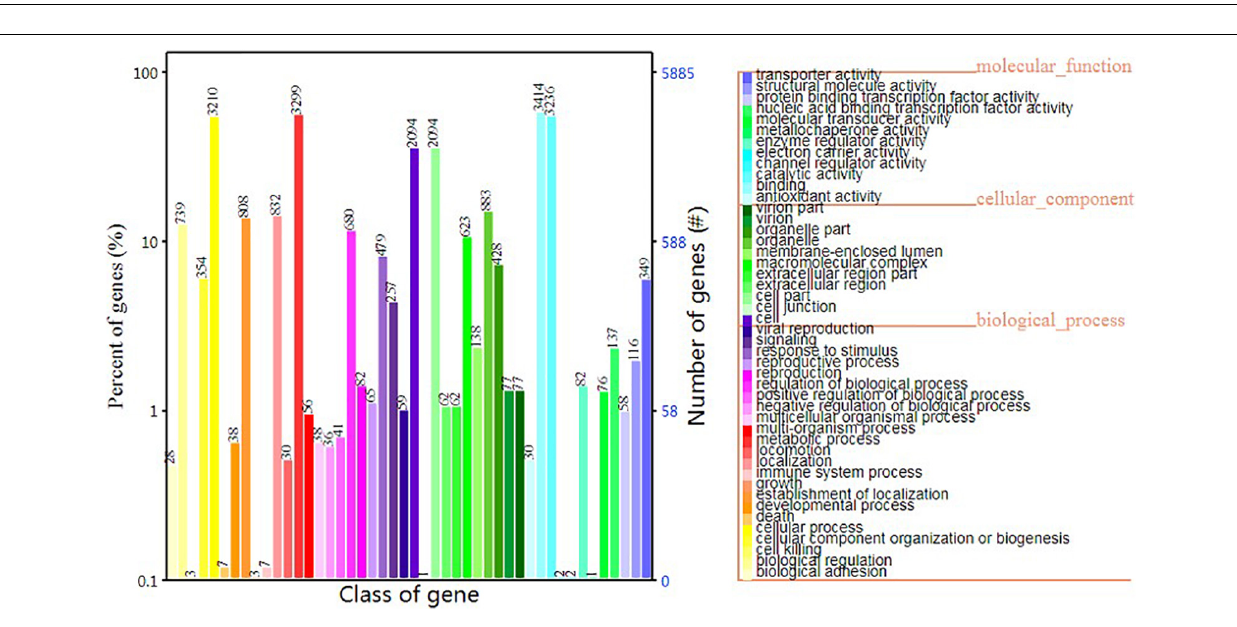
FIGURE 5 | Transporter Classification Database functional annotation of Sarcomyxa edulis genes.